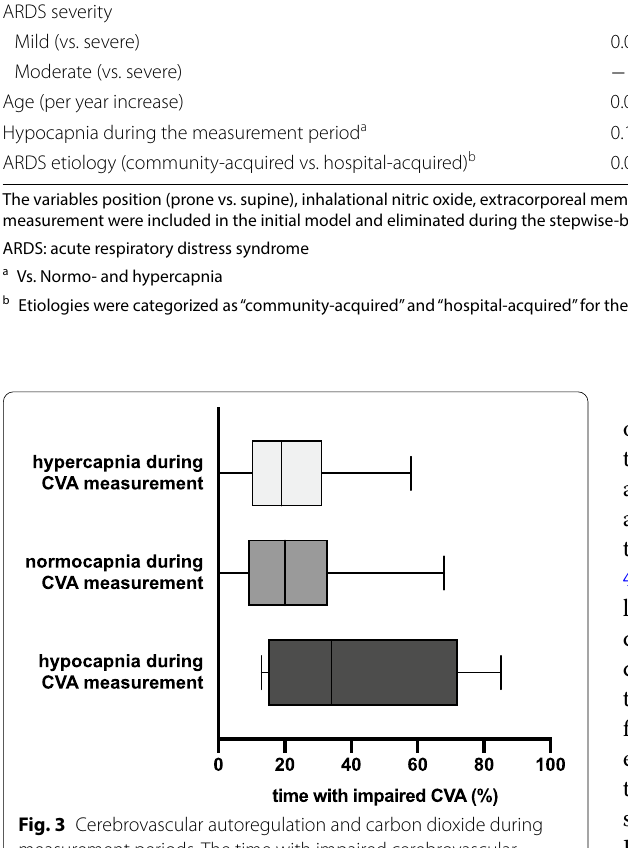
Fig. 3 Cerebrovascular autoregulation and carbon dioxide during measurement periods. The time with impaired cerebrovascular autoregulation (CVA, in % of the total monitoring time) is shown for patients with hypocapnia (PaCO measurement of CVA. Data are presented as median (boxes) with Tukey